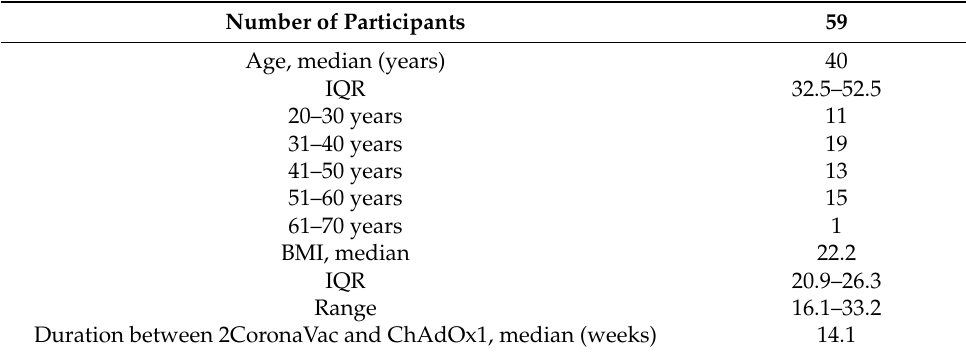
Figure 1. Vaccination and booster distribution and schedules. Table 1. Demographic data of participants who received primary vaccination by CoronaVac and ChAdOx1 as the first booster.